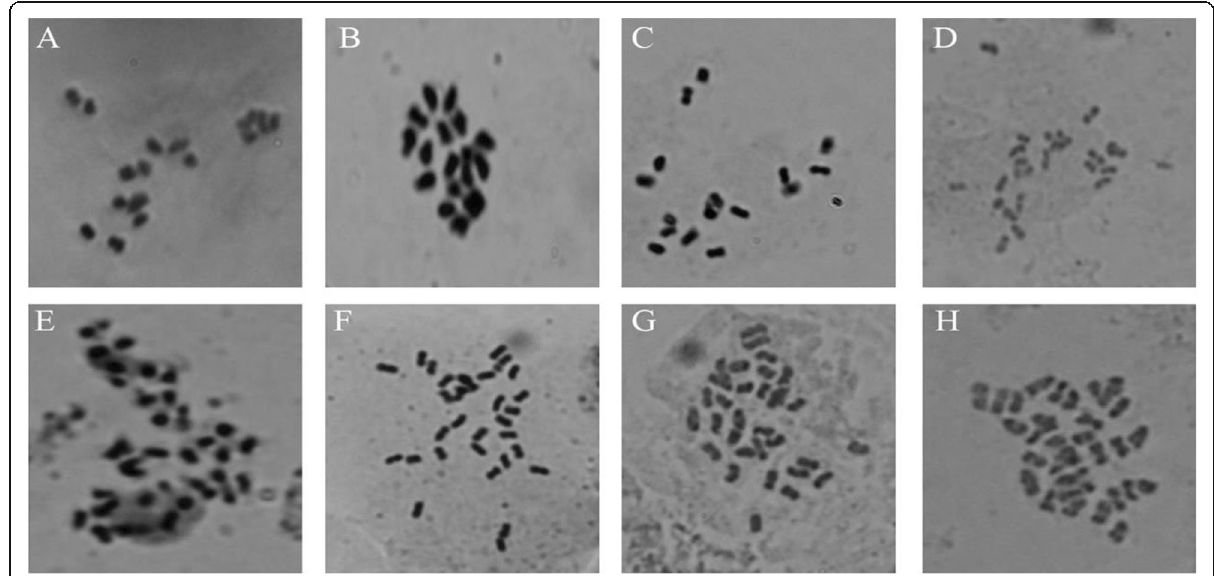
Fig. 1 Chromosome numbers analysis of alfalfa varieties using microscopy. Representative of the ploidy levels of varieties. a Iside 2n = 2x = 16. b Mu ş 2n = 2x = 16. c Bilensoy 2n = 2x = 16. d Bilensoy82 2n = 3x = 24. e Alsancak 2n = 4x = 32. f Plato 2n = 4x = 32. g Erzurum 2n = 4x = 30. h Konya 2n = 4x = 30